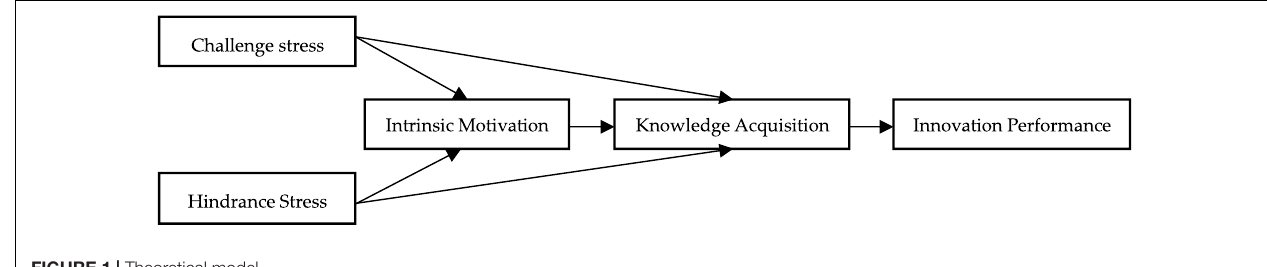
FIGURE 1 | Theoretical